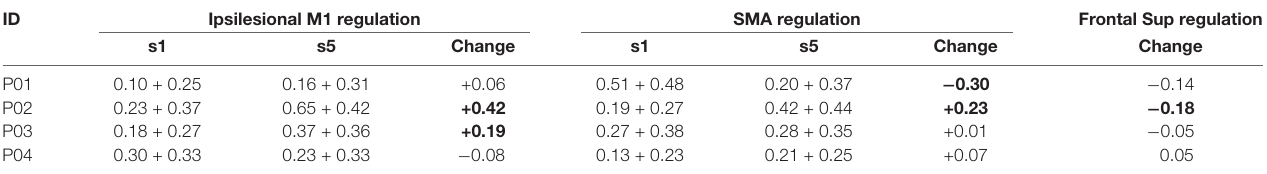
TABLE 2 | Multi-target fMRI control: individual results of blood-oxygen-level-dependent Neurofeedback (BOLD NF) scores (normalized percent signal change from baseline-rest).